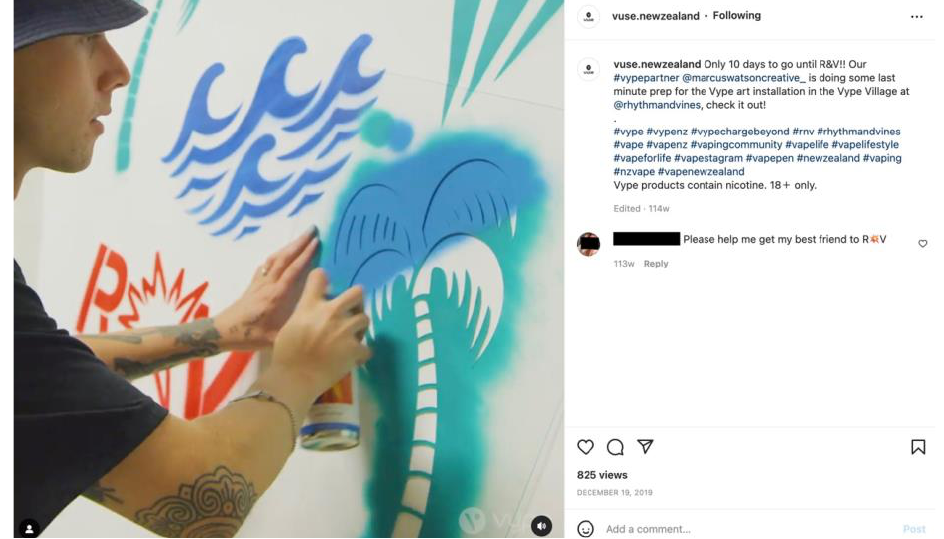
Figure 7. Example of an Instagram post with a social media influencer.